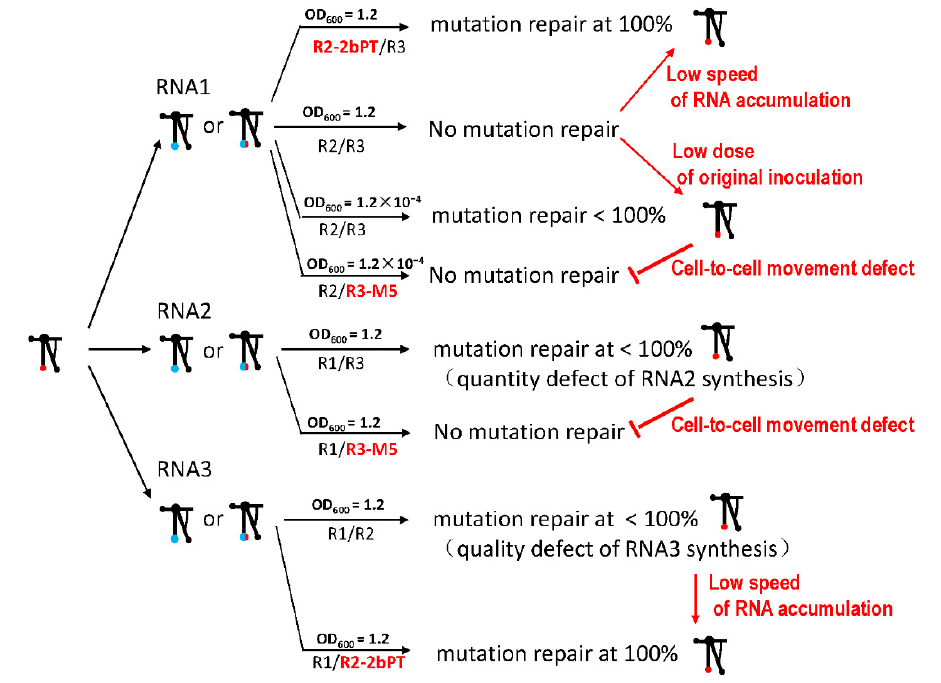
Figure 8. Summary of mutation repair of TLS mutation in different RNAs of CMV. Red arrow indicates the transition from no or low mutation repair to the high mutation repair; red T-shape indicates the transition from the presence of mutation repair to the absence of mutation repair. The words next to the arrow are the regulatory factors.